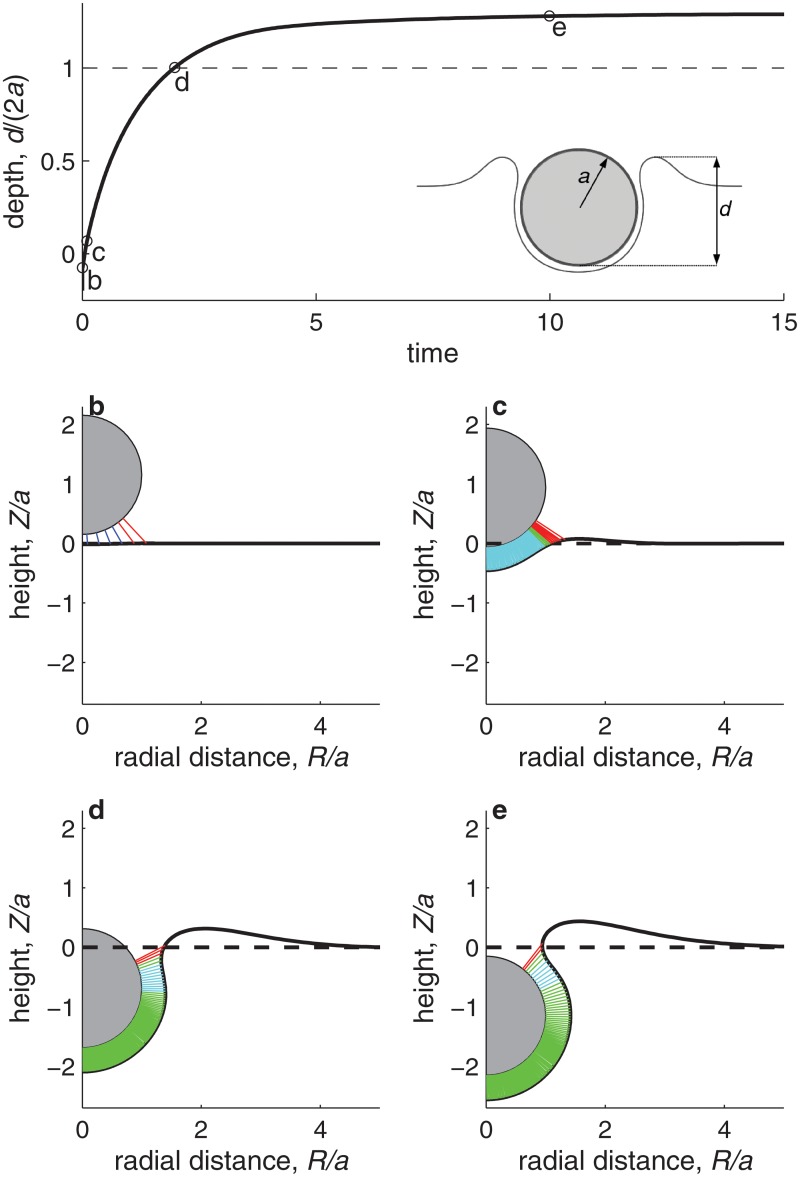
Kinetics of nanoparticle internalization.
a. Evolution of the particle internalization, measured by the depth-to-diameter ratio, d/(2a) (see inset), as a function of the elapsed non-dimensional time (one nondimensional time unit corresponds typically to one second). The computation is performed with a = 50 nm, Kd(0)/Kf=0.01μm−2 and otherwise with the best estimate of the parameter values listed in Table 1. The horizontal dashed line corresponds to the value d/(2a) = 1, which is the threshold where we define a particle as internalized. Four snapshots of the internalization process, indicated on plot a by circle markers denoted by ‘b’ to ‘e’ and corresponding to times t = 5 ⋅ 10−3, t = 10−2, t = 2.0, and t = 10.0 s, respectively, are presented in the plots b to e. Each snapshot shows the instantaneous membrane shape (full line), the initial membrane shape (dashed line), the particle (gray shaded circle), and the bonds formed between the particle and the membrane (short color lines). The density of color lines is proportional to the bond density. Dark blue, cyan, green, and red lines correspond respectively to bonds that are strongly compressed (l < 0.9λ), slightly compressed (0.9λ ≤ l < λ), slightly stretched (λ < l ≤ 1.1λ), or strongly stretched (l > 1.1λ).